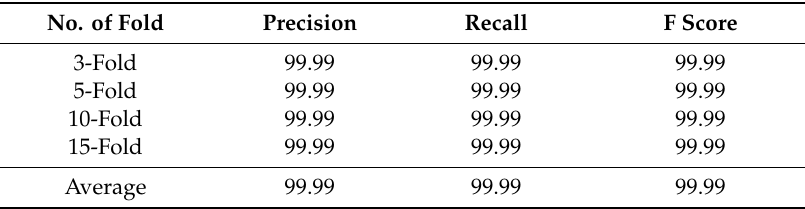
Table 7. Precision, Recall, and F Score for 10-Fold Cross-Validation.